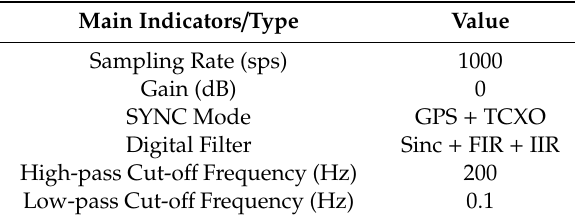
Table 2. Main parameters of the